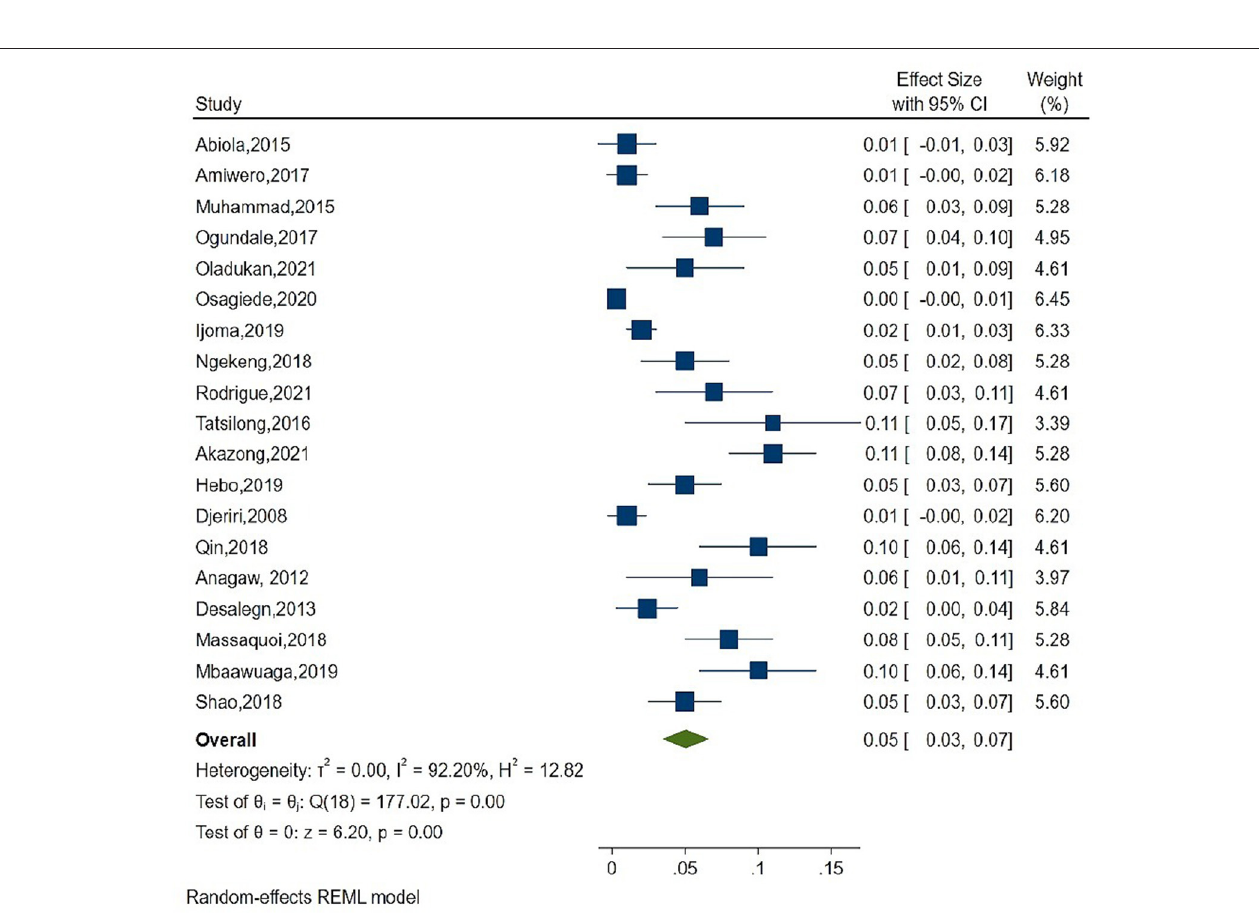
FIGURE 4 | Forest plot of seroprevalence estimate of the Hepatitis B infection among healthcare in Africa region.